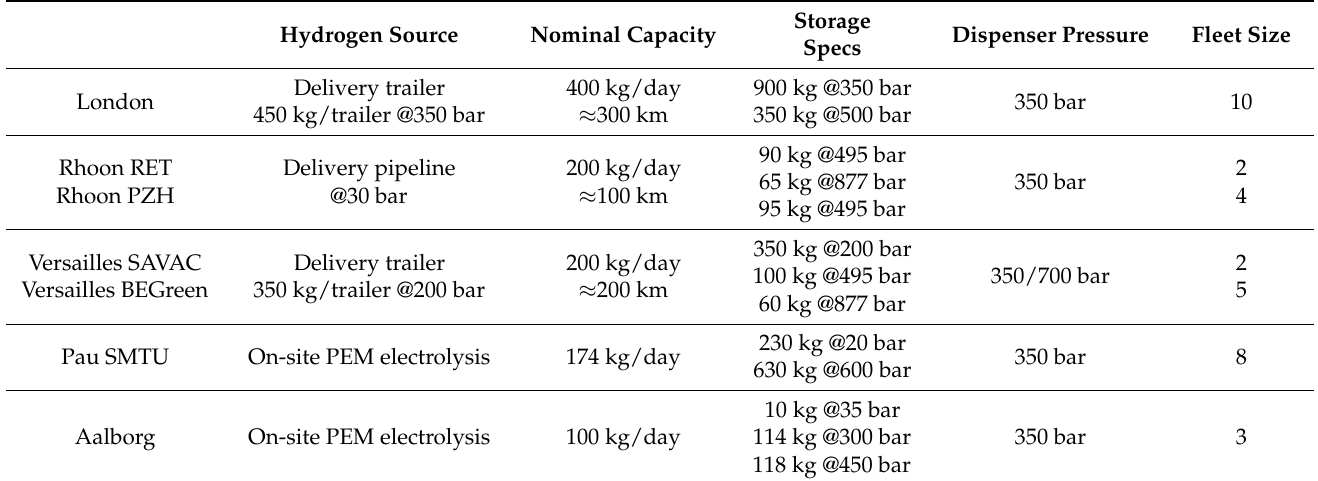
Table 1. Summary of the technical characteristics of the 3Emotion